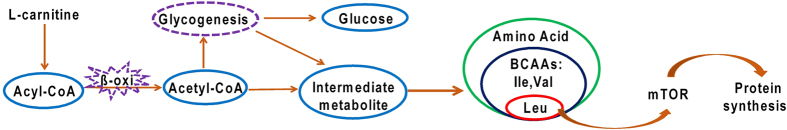
The possible mechanism of the L-carnitine on protein synthesis.